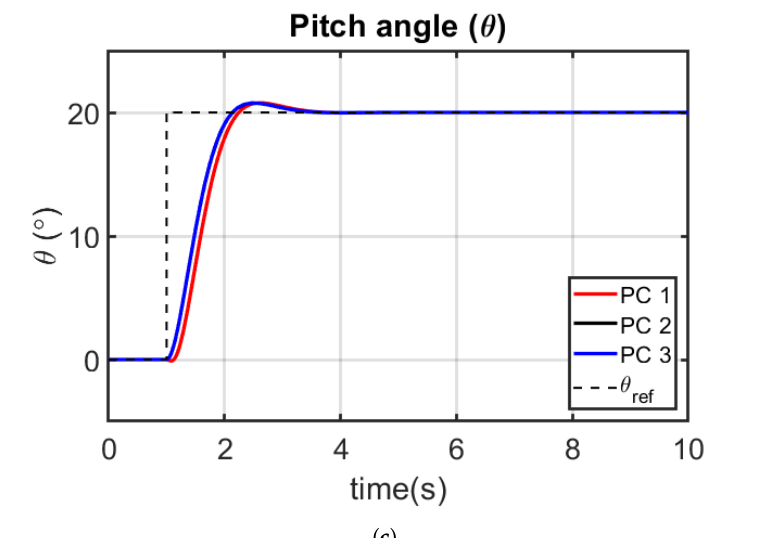
Figure 4. Time histories of the longitudinal states: ( a ) angle of attack ( α ) . ( b ) pitch rate ( q ) . ( c ) pitch angle ( θ ) .